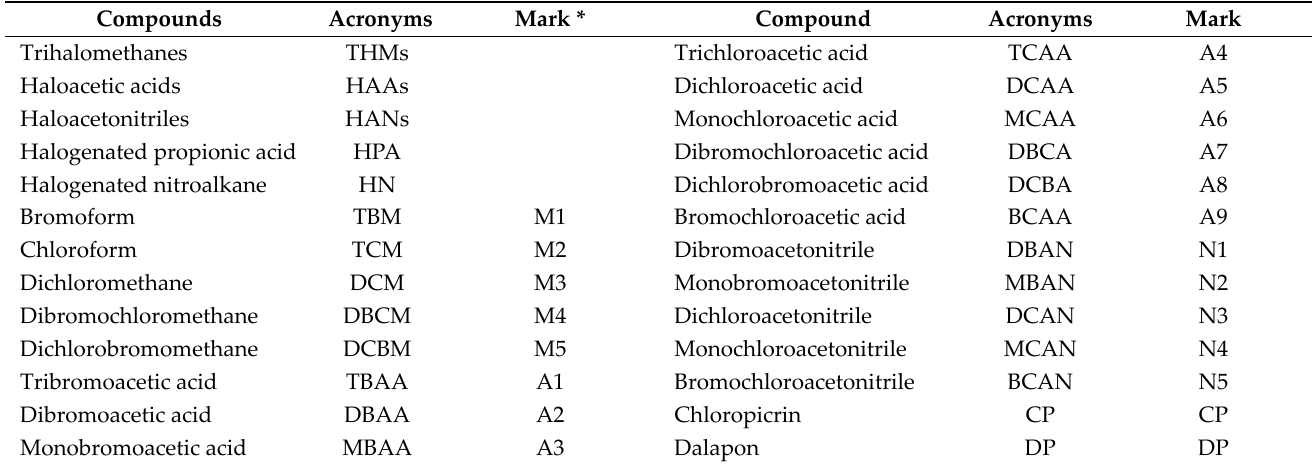
Table 2. Acronyms and mark of relevant chemicals indicating above detection